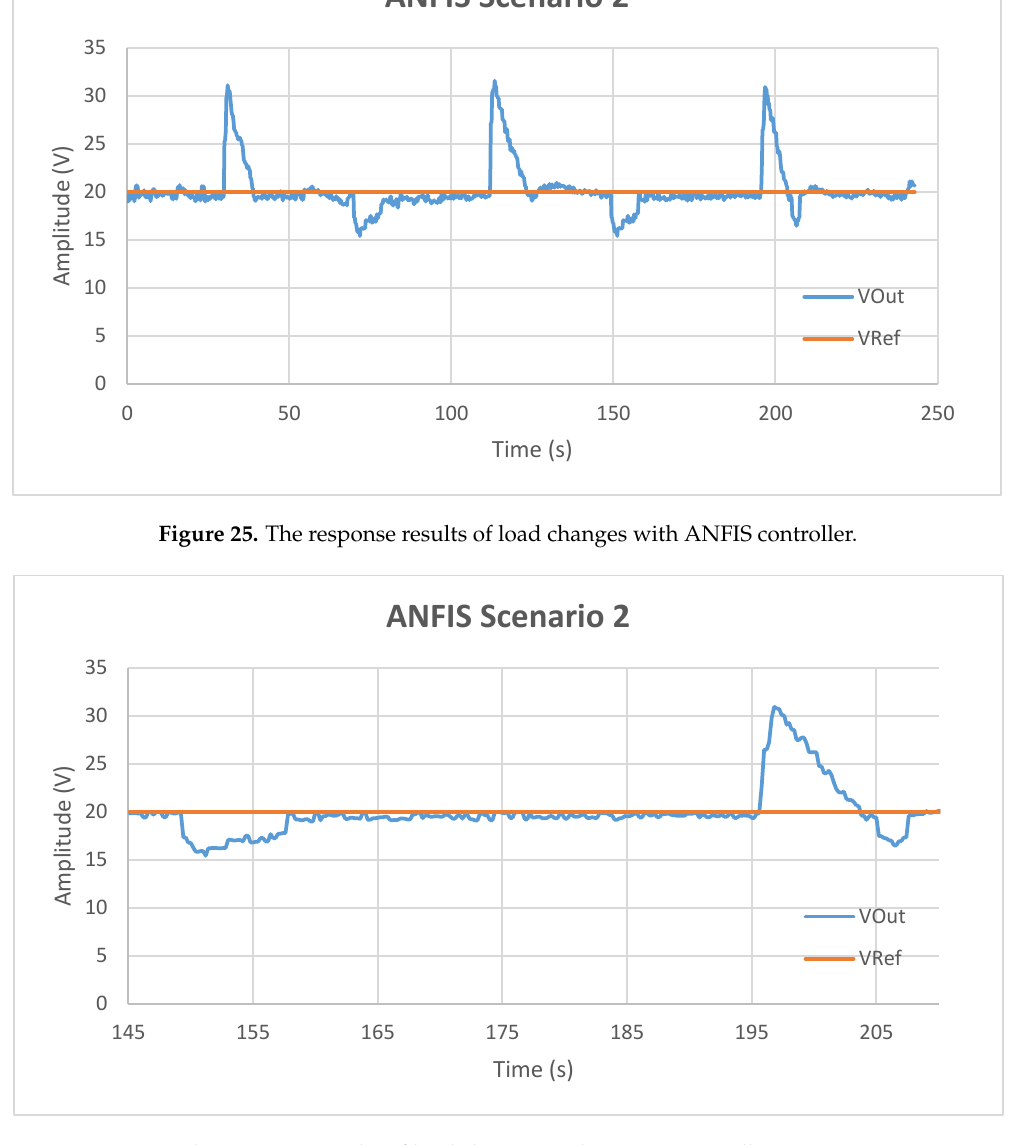
Figure 26. The response results of load changes with ANFIS Controller on 145 s to 210 s.